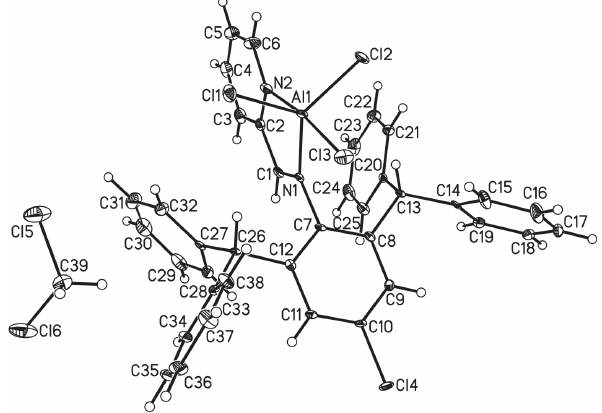
Table 2: Fractional atomic coordinates and isotropic or equivalent isotropic displacement parameters (Å 2